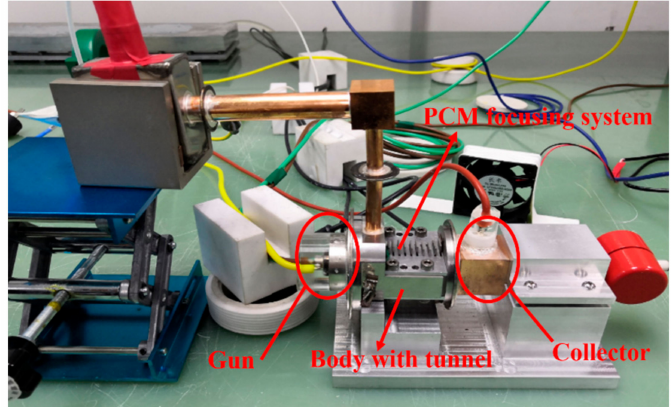
Figure 10. The beamstick in the testing site.